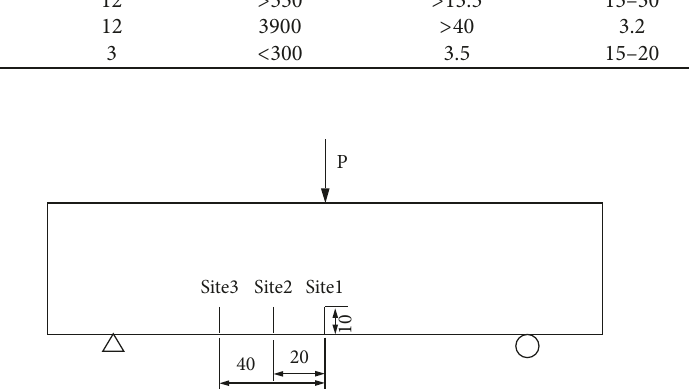
Figure 1: Presawed position diagram (unit: mm). Table 4: Bending test